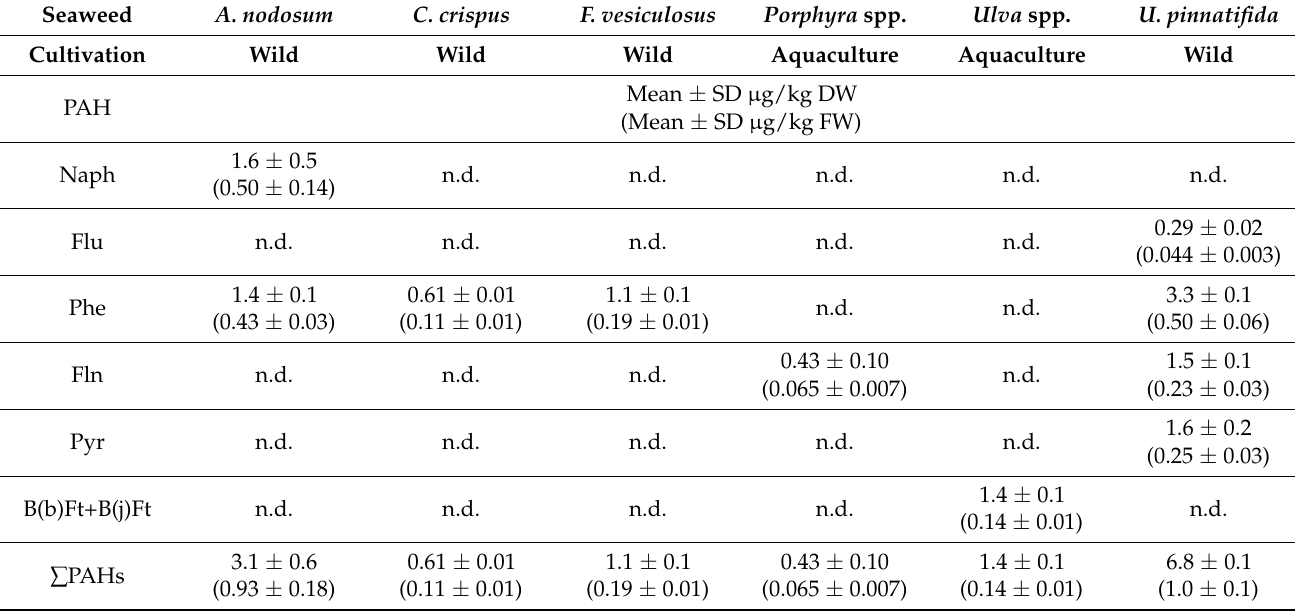
Table 3. PAHs levels detected in commercial seaweeds µ g/kg DW ( µ g/kg FW). Seaweed